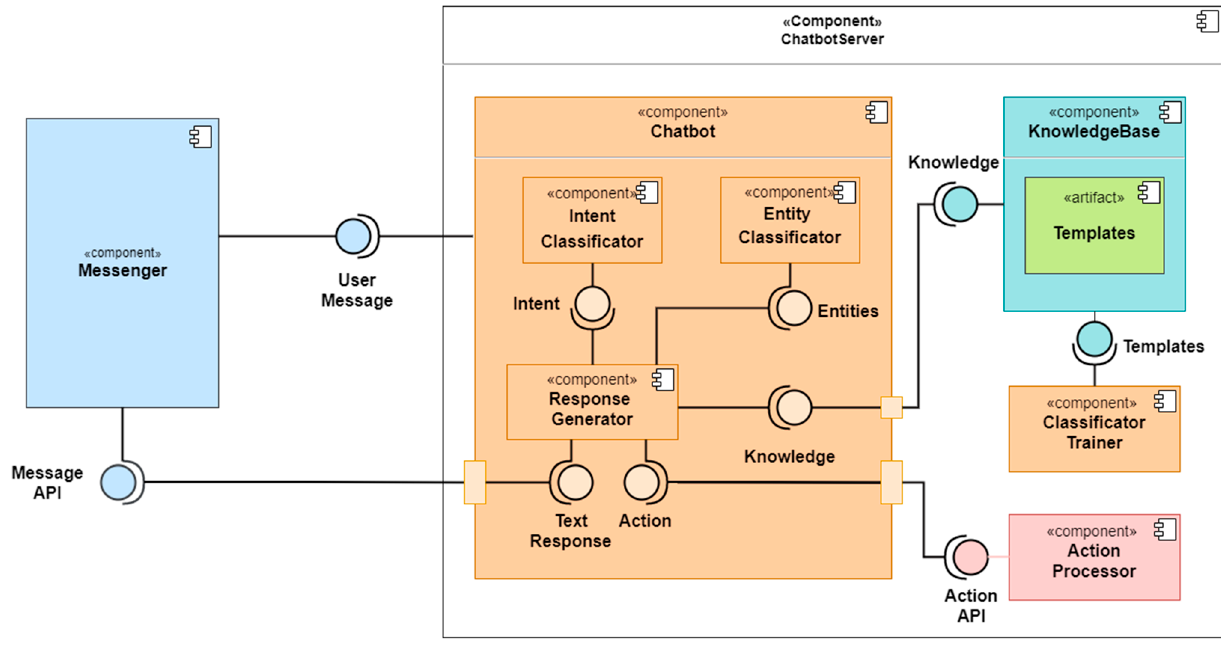
Figure 6. UML diagram of the application’s components.